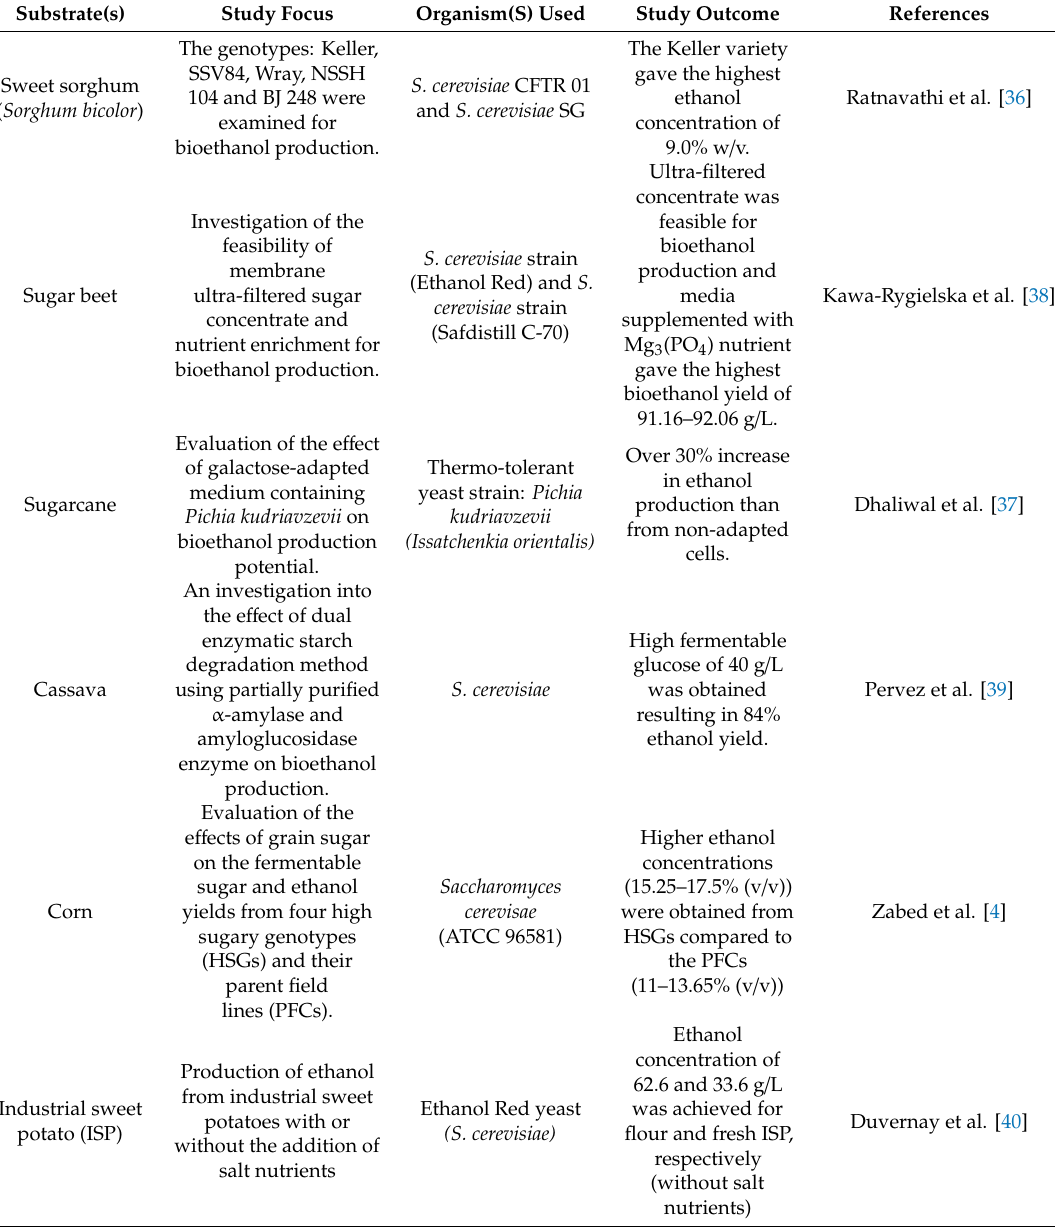
Table 1. Studies towards the improvement of first-generation